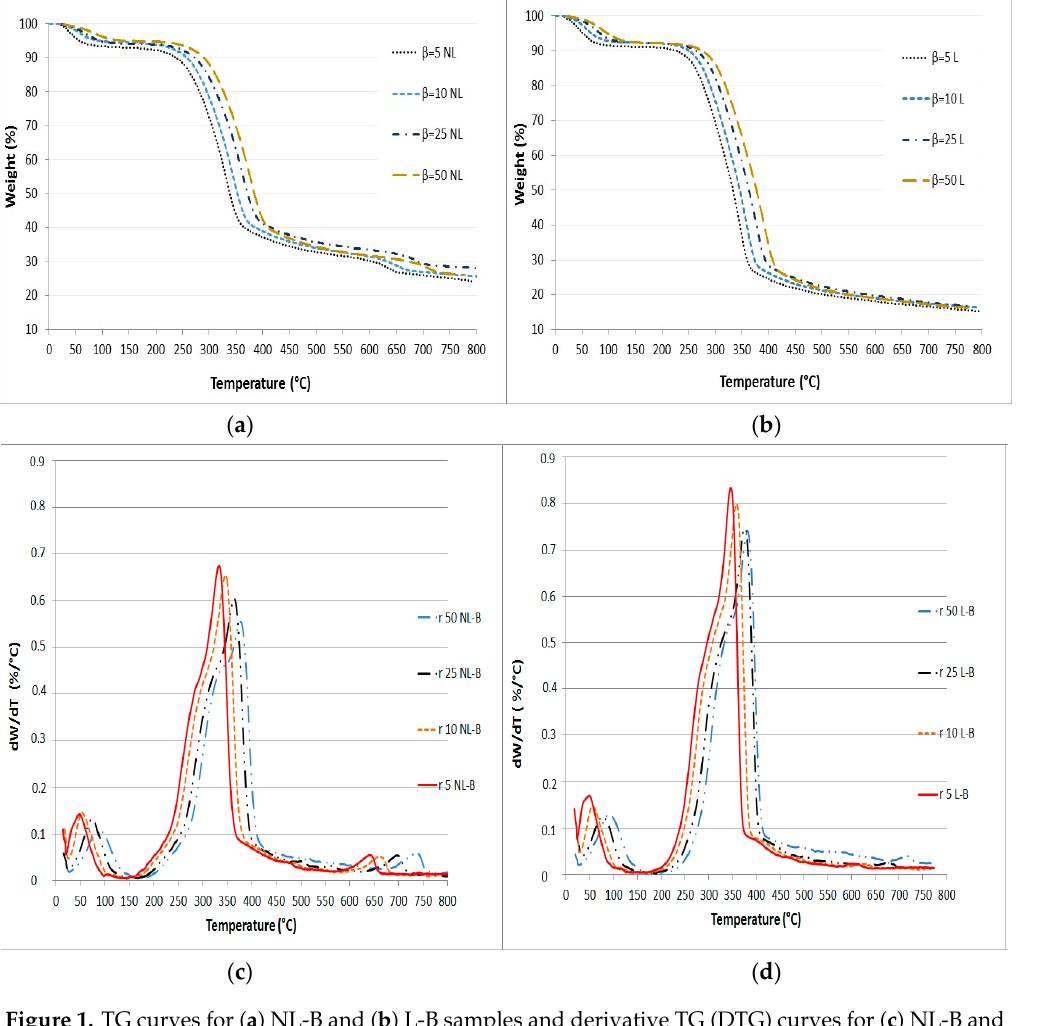
Figure 1. TG curves for ( a ) NL-B and ( b ) L-B samples and derivative TG (DTG) curves for ( c ) NL-B and ( d ) L-B at different heating rates.